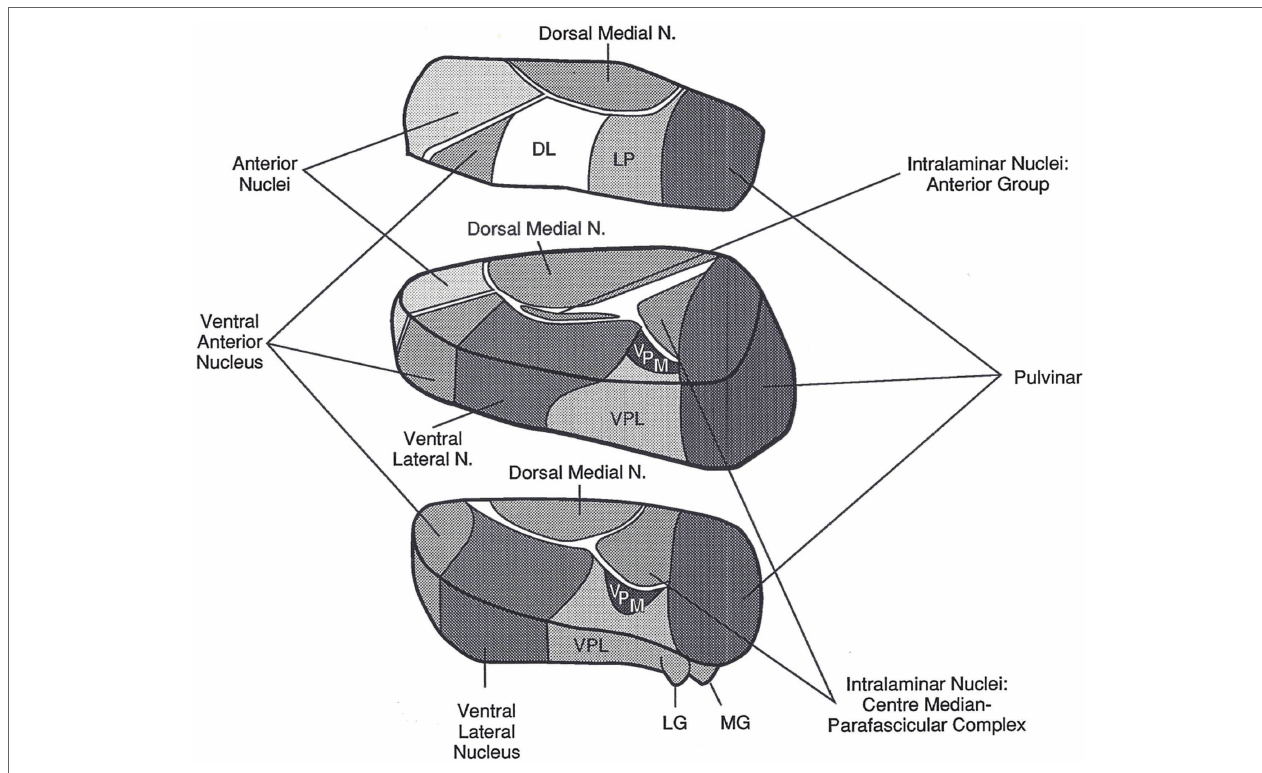
FIGURE 1 | The left thalamus. This superolateral view of the left thalamus in three blocks shows its major nuclei. The current article focuses on the pulvinar, the large nucleus in the posterior most portion of the thalamus, and on the VA/VLa region, consisting of the ventral anterior nucleus (VA) and the anterior portion of the ventral lateral nucleus (VLa). The internal medullary lamina are the “white” bands of fibers separating many of the nuclei. DL, dorsal lateral nucleus; LG, lateral geniculate nucleus; LP, lateral posterior nucleus; MG, medial geniculate nucleus; N, nucleus; VPL, ventral posterior lateral nucleus; VPM, ventral posterior medial nucleus. Reprinted from Crosson (1992). Copyright 1992, with permission from Guilford